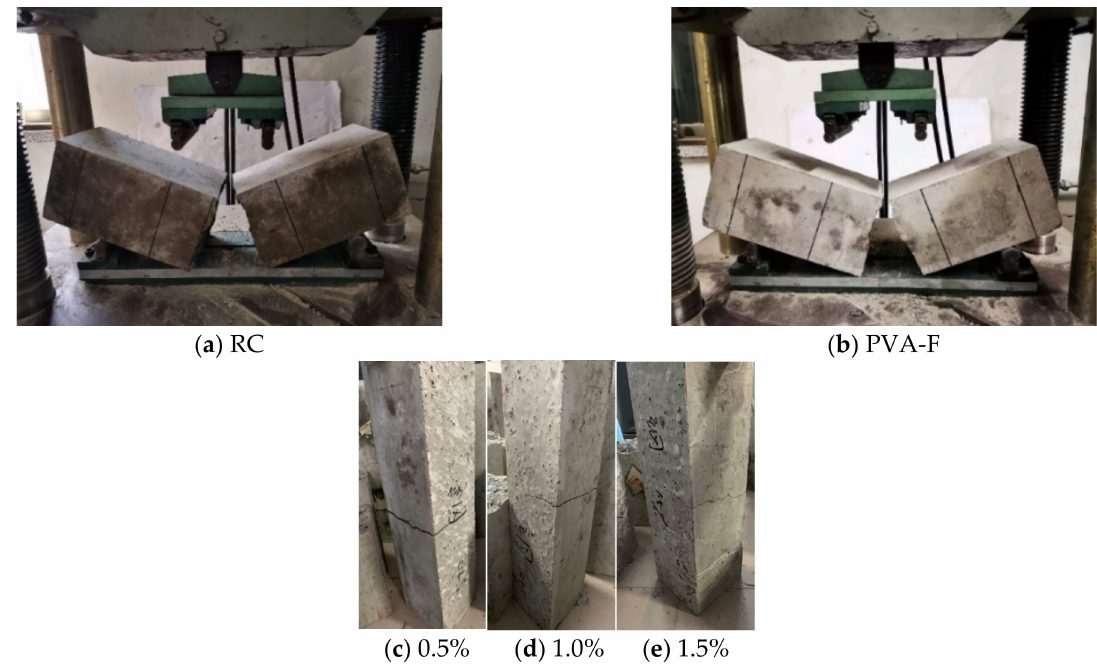
Figure 9. Failure patterns of flexural